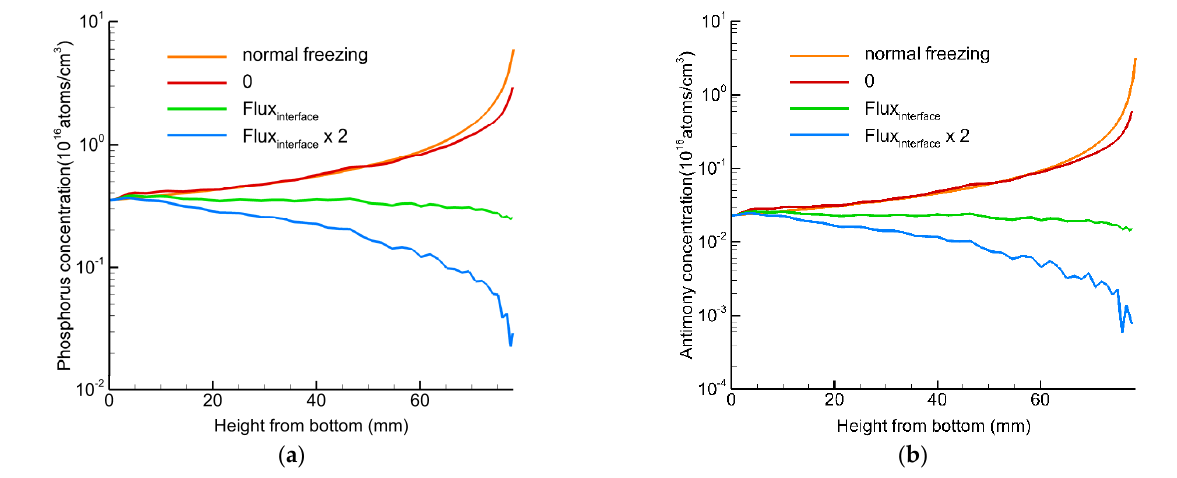
Figure 5. Distribution of the ( a ) phosphorus and ( b ) antimony concentration in the center of the crystal along the vertical direction with different evaporation fluxes at the melt surface. The evaporation flux at the melt surface was (i) 0, (ii) the same as the incorporation flux at the melt–crystal interface, and (iii) twice as large as that of case (ii).